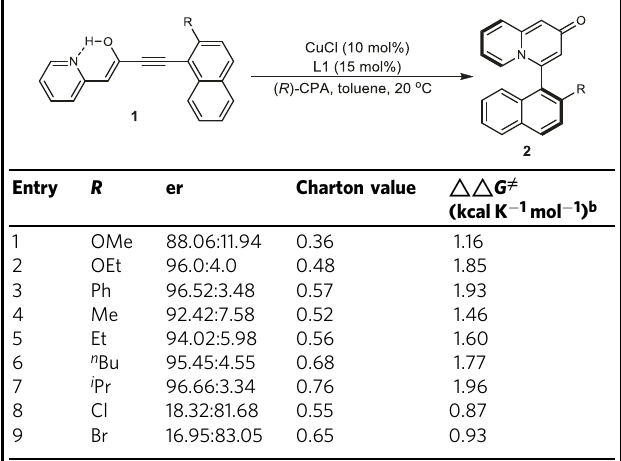
Table 2 Examination of steric effect on enantioselectivity a .